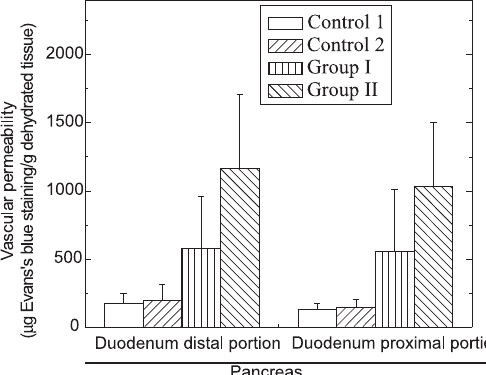
Figure 1. Comparison of vascular permeability (mg of Evans’ blue stain/g dehydrated tissue) of duodenum proximal and duodenum distal portions of pancreas. (n = 10; P < 0.05)